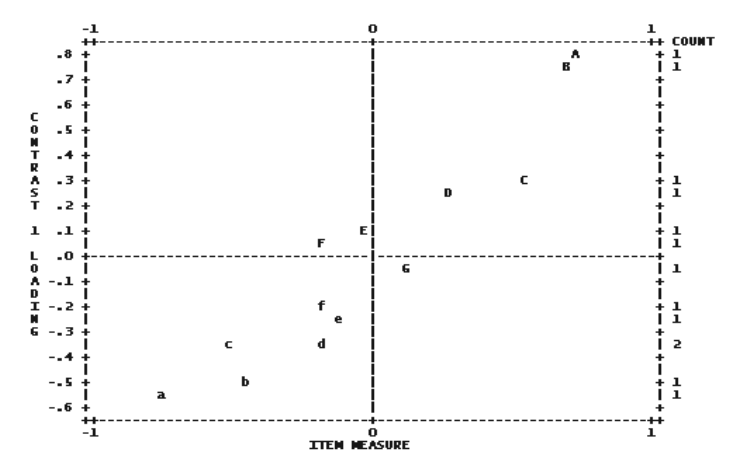
Figure 1 – Standardized residual contrast 1 plot; B corresponds to item 9 and A to item